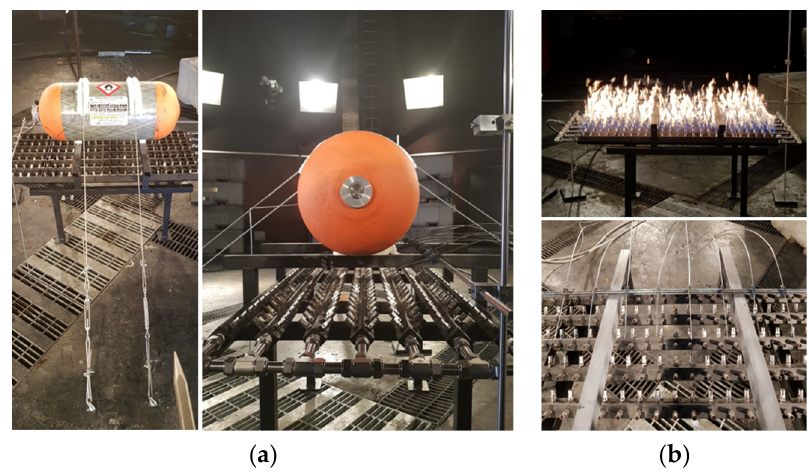
Figure 2. Hydrogen tank and heating source: ( a ) hydrogen tank (type Ⅳ ); ( b ) heating source. Figure 1. Schematic of experimental setup.